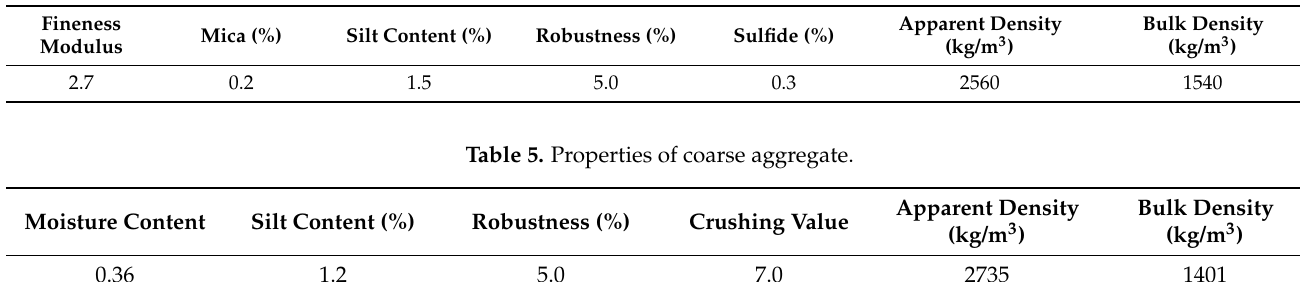
Table 4. Properties of natural river sand.